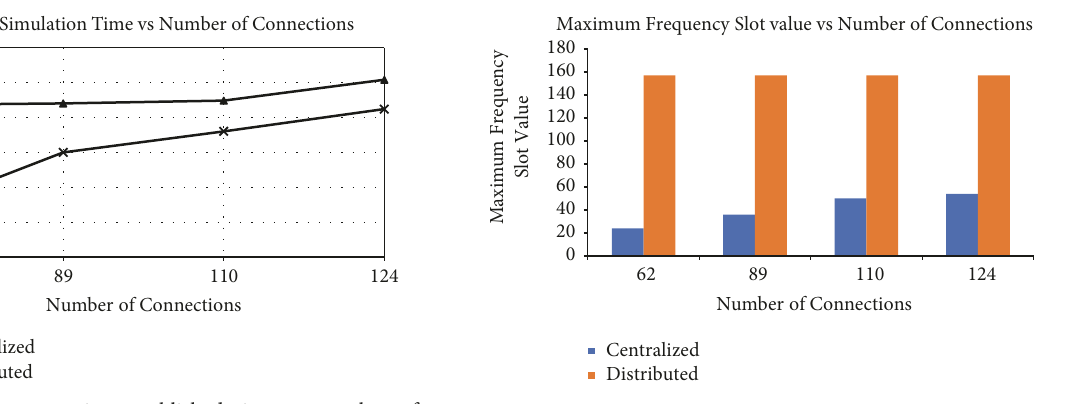
Figure14:Maximumfrequencyslotvaluevsnumberofconnections in Germany topology.